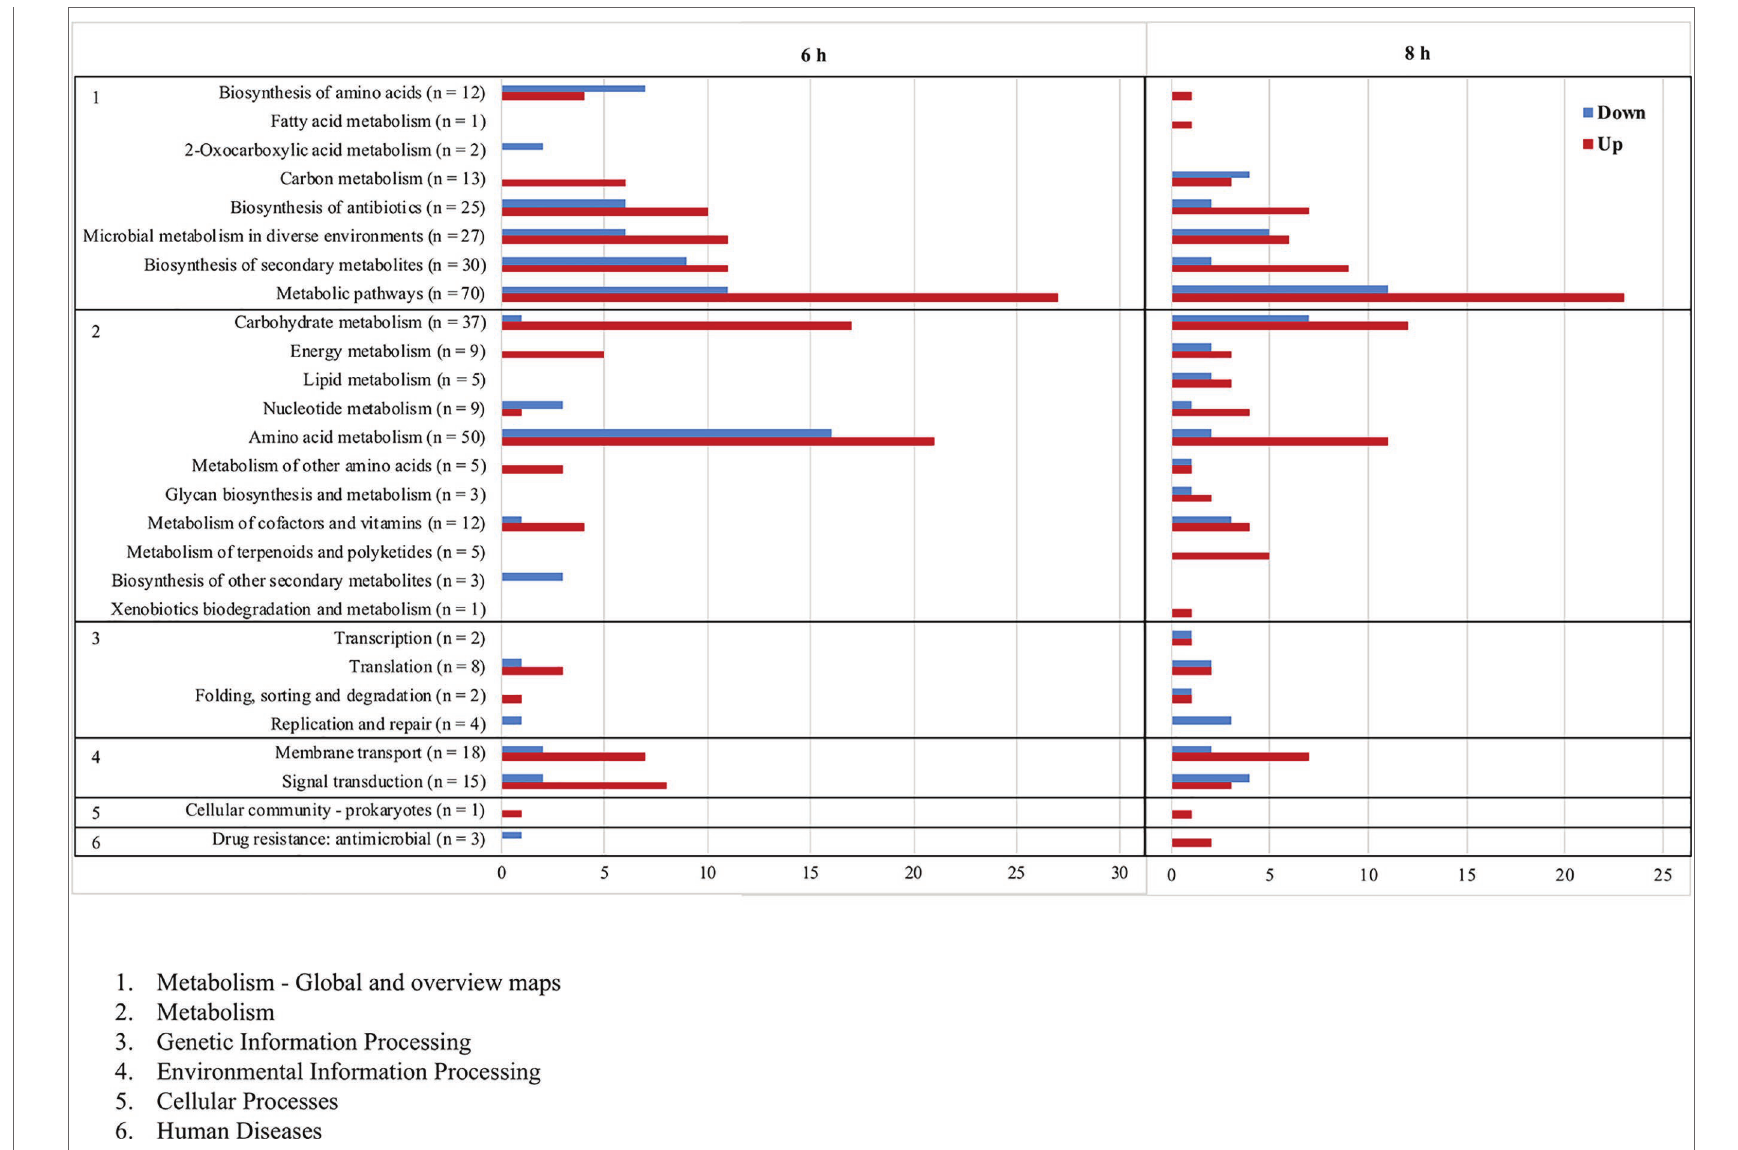
FIGURE 6 | Functional classification according to KEGG pathways of genes significantly upregulated (red) and downregulated (blue) after 6 and 8 h of growth of the ∆ lytSR strain compared to the WT strain. Numbers in parentheses represent the total number of genes affected within the genome in each functional